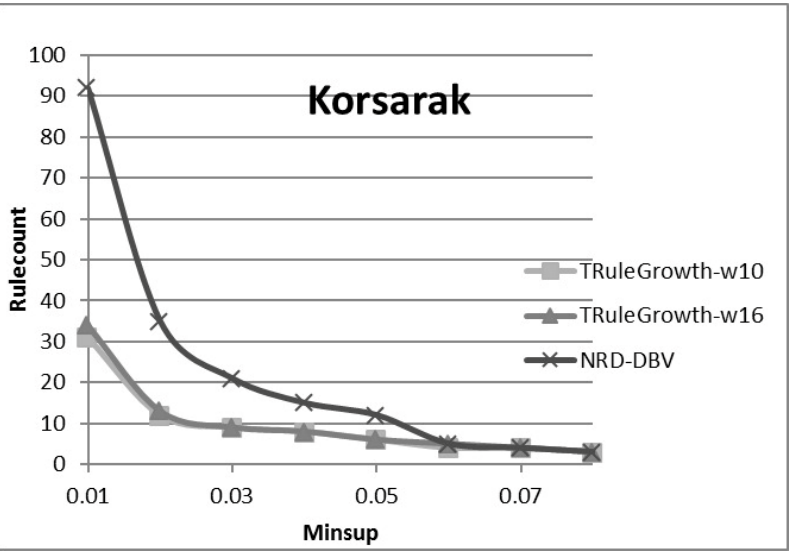
Figure 11. Comparison between the No. of rules generated for the TRuleGrowth and the NRD-DBV for (Korsarak) dataset .